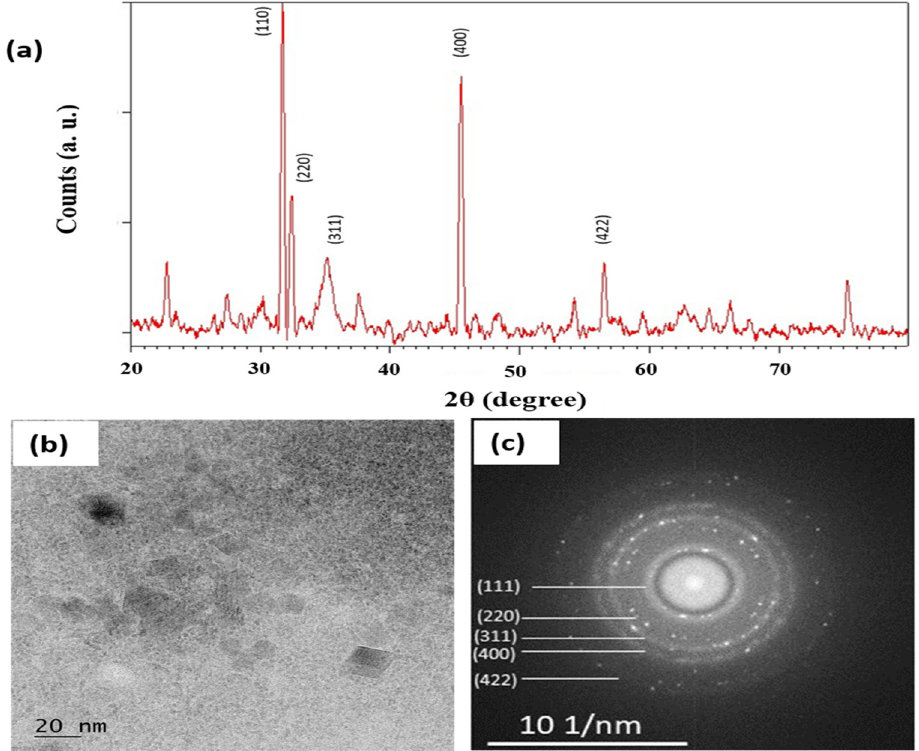
Figure 5. ( a ) XRD spectrum of biosynthesized IONPs and ( b )TEM images of biosynthesized IONPs, and ( c ) SAED image